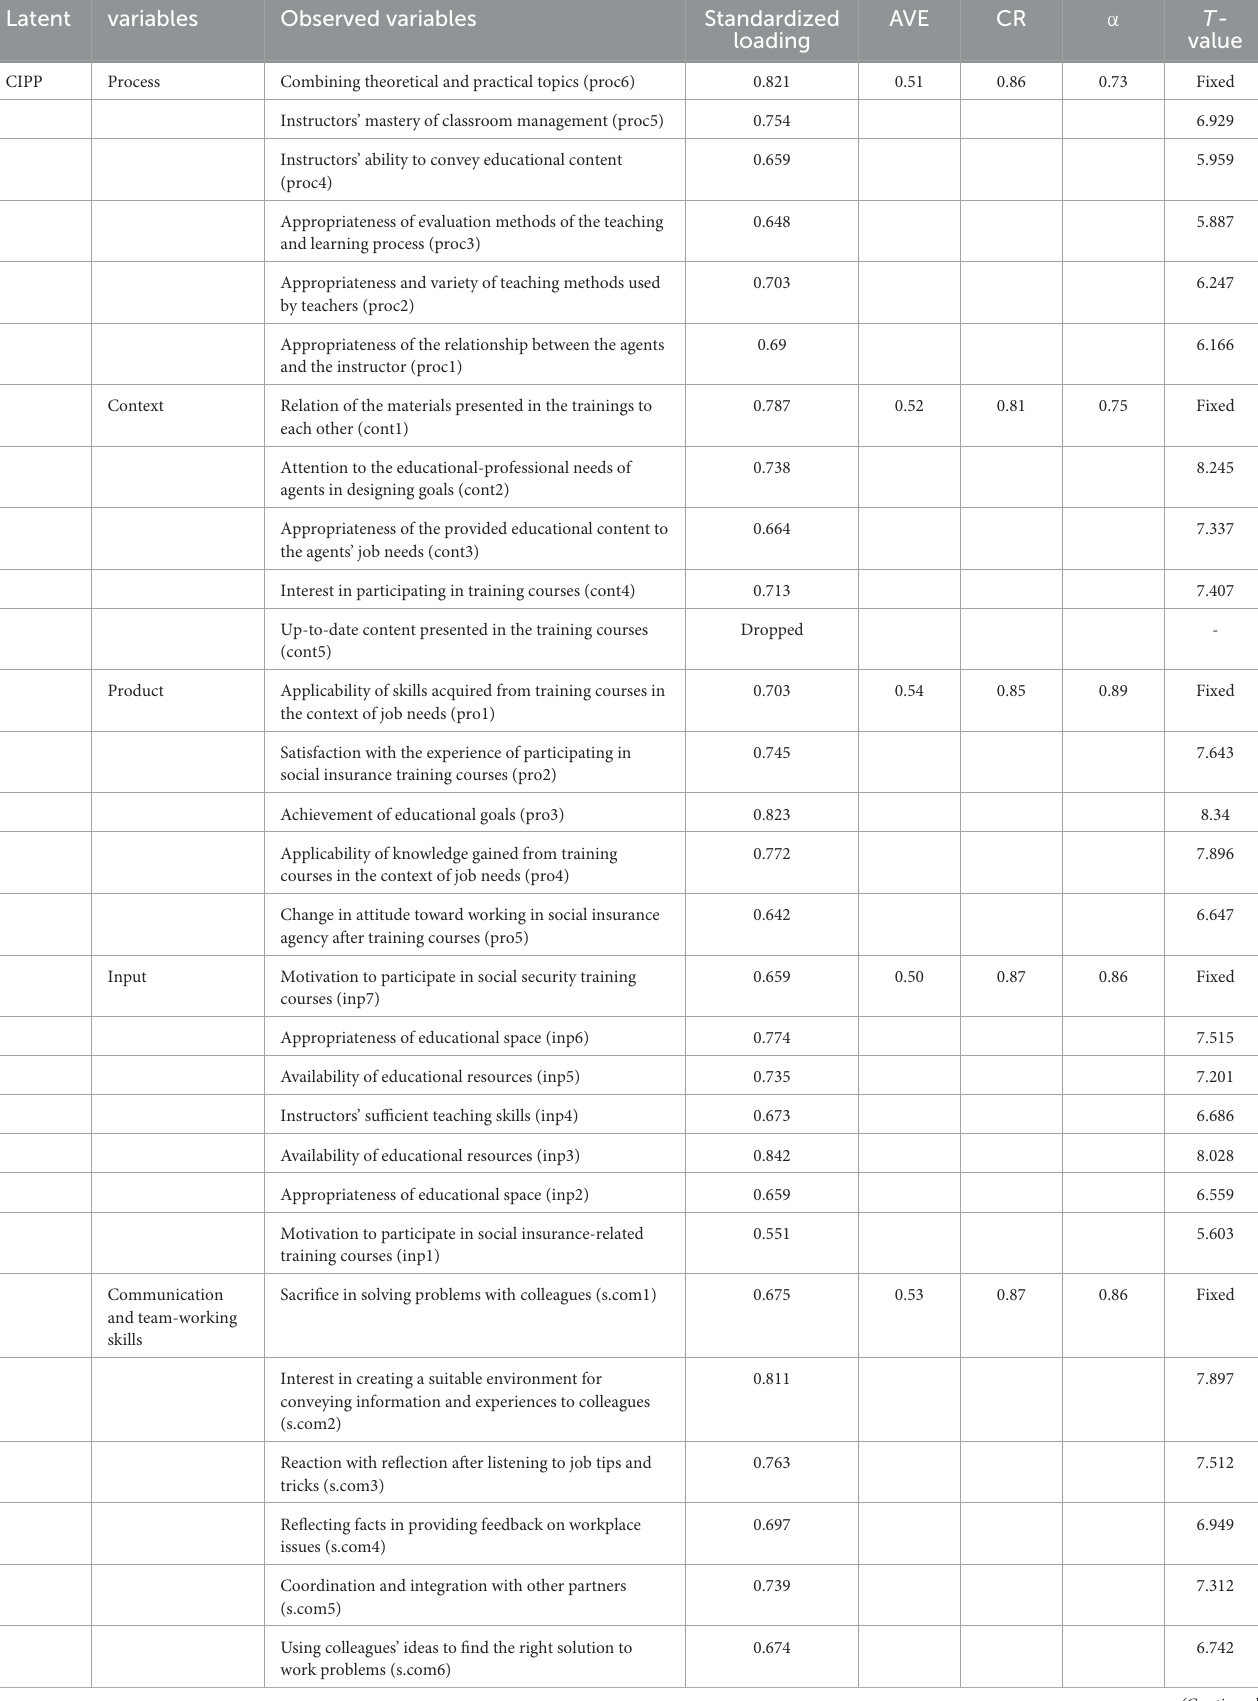
TABLE 1 The coefficient of measurement and significance level of confirmatory factor analysis and the validity and reliability of the